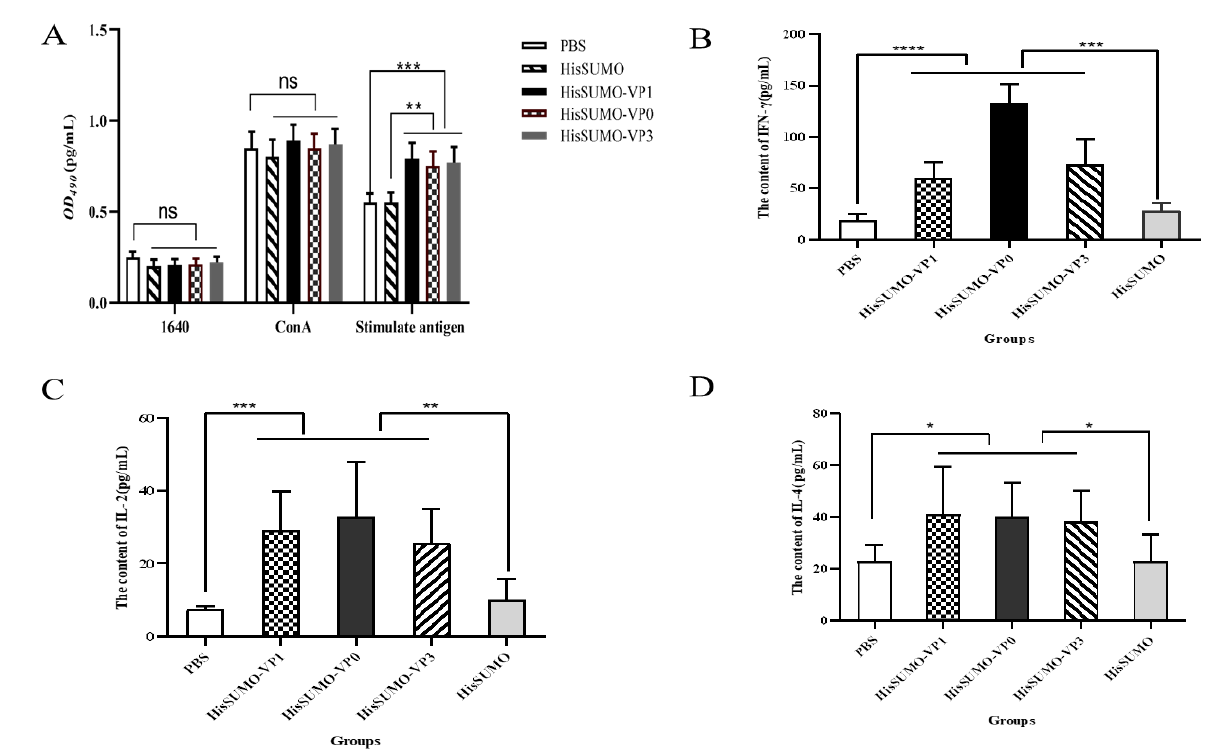
Figure 5. The graphs A – D show the lymphocyte proliferation and cytokine production levels elicited by the recombinant proteins, respectively. The master legend is used and each value (pg/mL) in the bar diagrams represents Mean ± S.E.M. ( n = 7); * p < 0.05; ** p < 0.01; and *** p < 0.001, when compared with control groups. Graph ( A ) the absorbance at 450 nm was detected to evaluate lymphocyte proliferative concentration in (pg/mL). The results were presented as the ratio of stimulated sample to unstimulated sample at OD450 nm (stimulation index). Details of the experimental adjustments are the same as described in the methodology. Briefly, the negative control group of animals (1640) did not receive any treatment. The (ConA) which is poured by Concanavalin A (5 ug/mL), indicating the activation of B and T cells, compared with the control groups; ns = non-significant. In the group stimulated with the three recombinant FMDV proteins alone, but not treated with ConA, the concentration of lymphocytes had a significant difference ** p < 0.01 and *** p < 0.001, when compared with the control groups. Graph ( B – D ) The one-way ANOVA (statistical analysis of variance) was demonstrated to figure out the mean variation of the serum levels of cytokines (IFN- γ, IL -4 and IL-2) in immune response among treatment groups and control groups (ns p > 0.05,* p < 0.05,** p < 0.01, *** p < 0.001). ( B ) The concentrations of IFN in the five different groups. The p values according to unpaired t-test **** p < 0.0001. ( C ) Represents the concentration of IL-2. The IL-2 concentration in mice treated with the recombinant FMDV protein compared to PBS groups **** p < 0.0001 and to the negative control group ** p < 0.01. ( D ) Shows the concentration of IL-4. The p values according to unpaired t-test * p < 0.05.